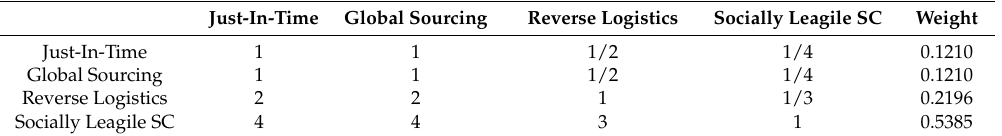
Table A12. Pairwise Comparison of Alternative w.r.t. sub-criterion Philanthropy.